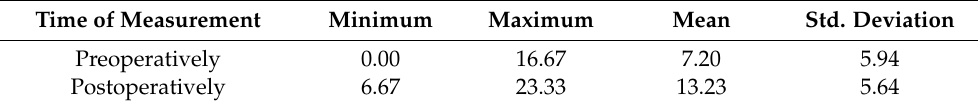
Table 2. Measurements of central dispersion for the mean number of microcracks in the root canal walls of severely curved canals before and after instrumentation (n =